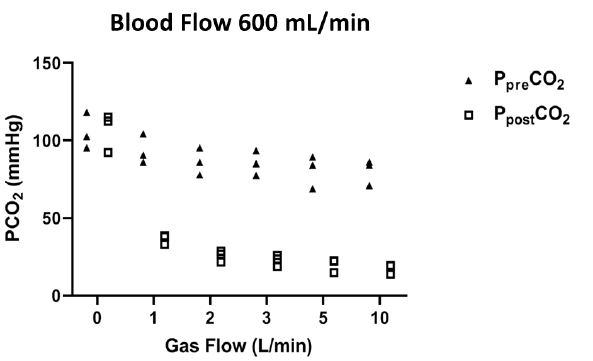
Figure 4. Median pre and post-membrane PCO 2 under different sweep gas flow conditions (0, 1, 2, 3, 5 and 10 L/min) and a fixed blood flow rate of 600 mL/min. Table 2. Operational characteristics of CO 2 RESET in the three treated pigs.